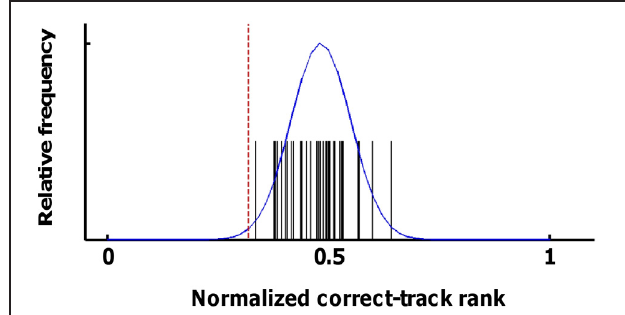
FIGURE 4 | Statistical distribution of correct-track ranks in the absence of signal. Here we show the distribution of the correct-track ranks observed when applying pattern classification on the data from the white-matter ROI using the various sources of information and ROIs that are shown in Figure 6 . The black spikes represent the individual values, the blue line is a normal distribution fitted to these data. The red line corresponds to the statistical threshold used for determining whether decoding performance was better than